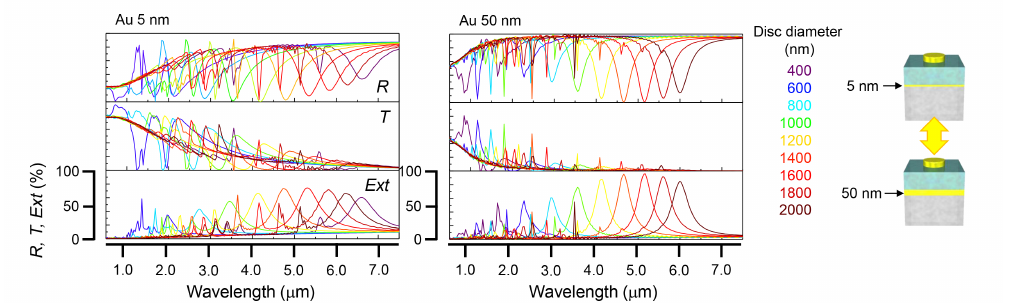
Figure 3. Numerical simulations. Influence of thickness of the bottom mirror in MIM. FDTD simulations for different thickness thin-Au MIM metasurface without adhesion